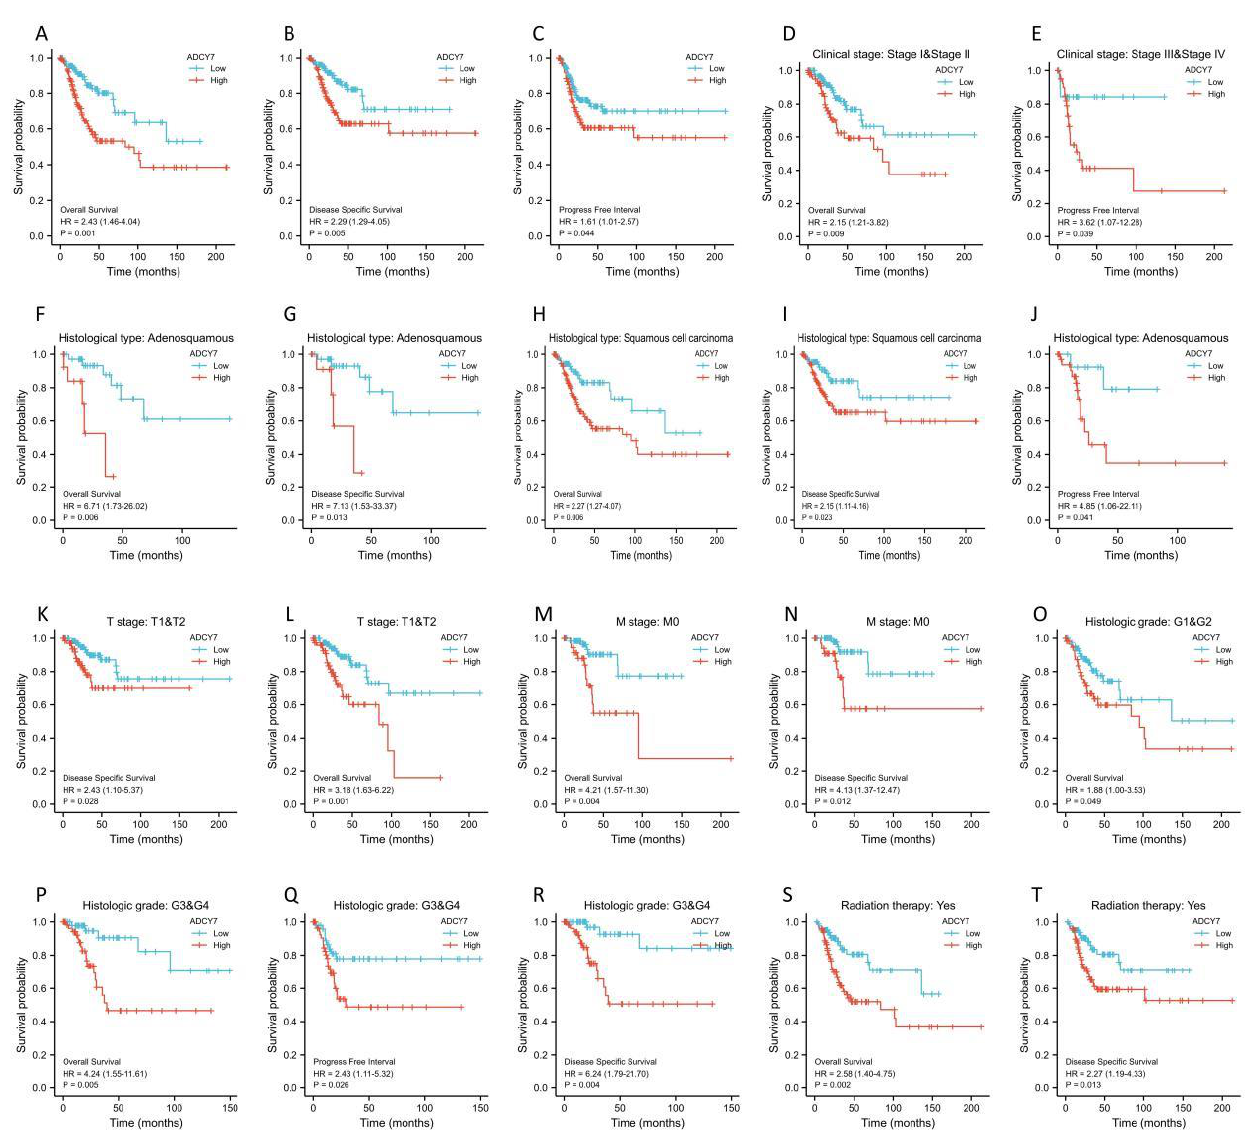
Figure 3. The predictive value of ADCY7 in cervical cancer. ( A – C ) Survival curves show OS, DSS, and PFI rates of CESC patients with high ADCY7 expression; ( D – T ) survival curves show clinical subgroup analysis of CESC patients with high ADCY7 expression.